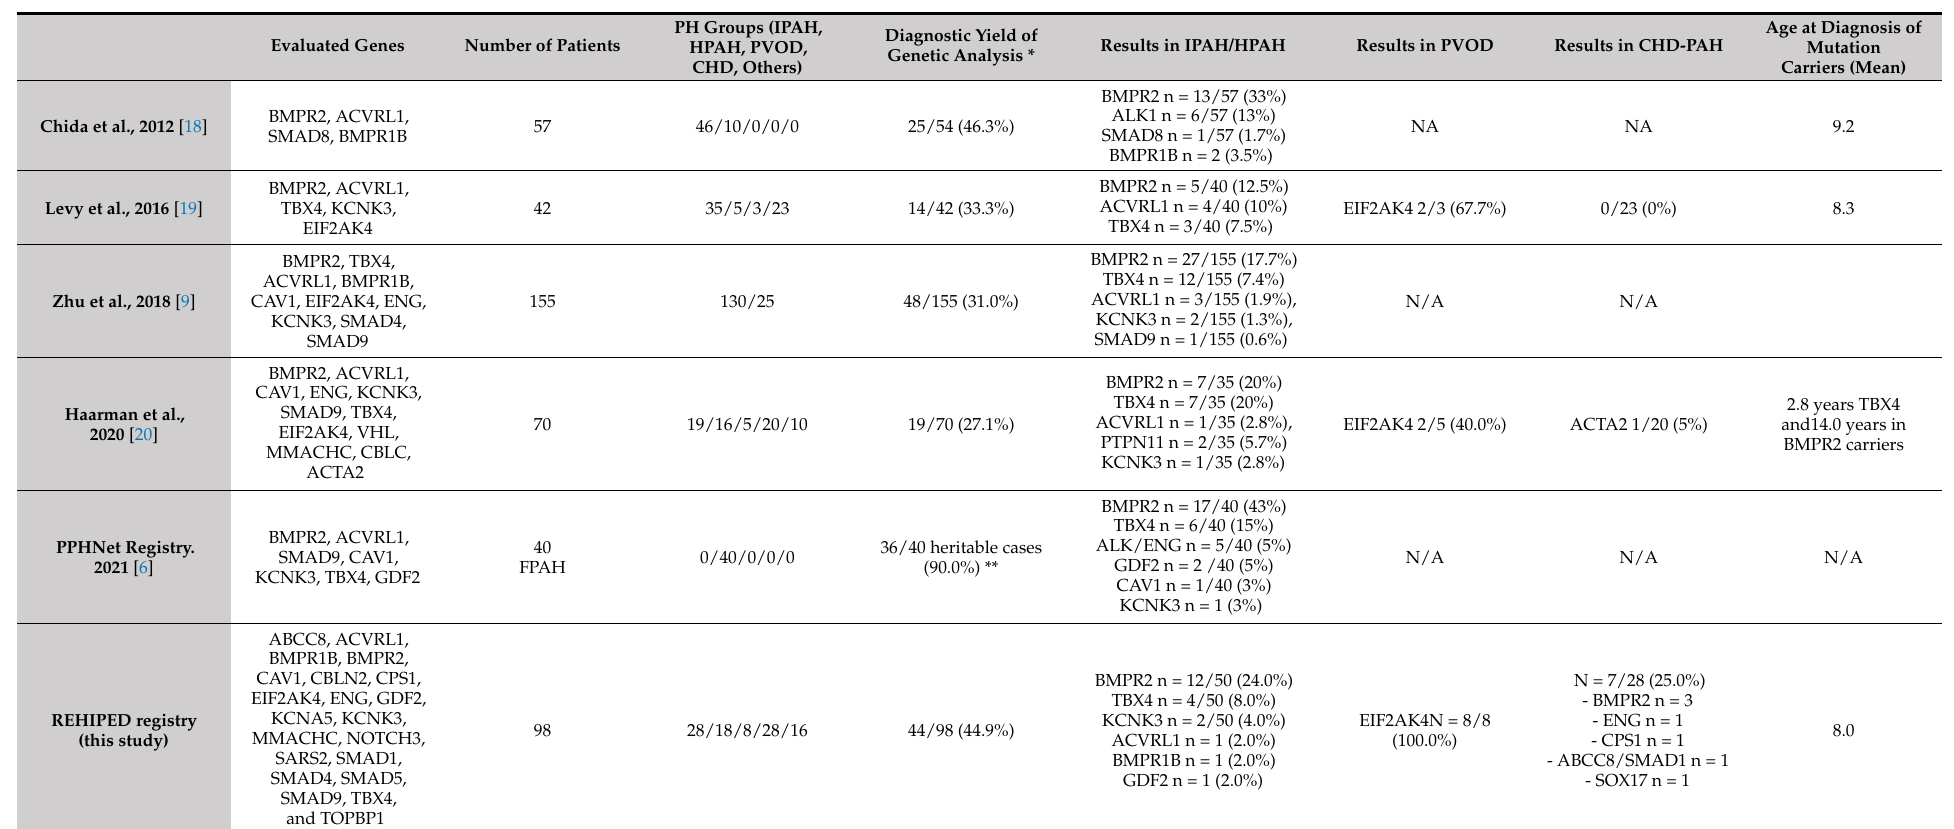
Table 2. Comparison between published studies analyzing genetics in pediatric pulmonary hypertension. CHD (congenital heart disease); FPAH (familial pulmonary arterial hypertension); HPAH (heritable pulmonary arterial hypertension); IPAH (idiopathic pulmonary arterial hypertension); N/A (not available); PH (pulmonary hypertension); PVOD (pulmonary veno-occlusive disease). * Pathogenic or likely pathogenic variants. ** Only includes heritable cases after genetic analysis (includes familial cases without any significant genetic variant and heritable cases with pathogenic or likely pathogenic variants). PH Groups (IPAH, Diagnostic Yield of Evaluated Genes Number of Patients HPAH, PVOD, Genetic Analysis * Results in IPAH/HPAH Results in PVOD Results in CHD-PAH CHD, Others)